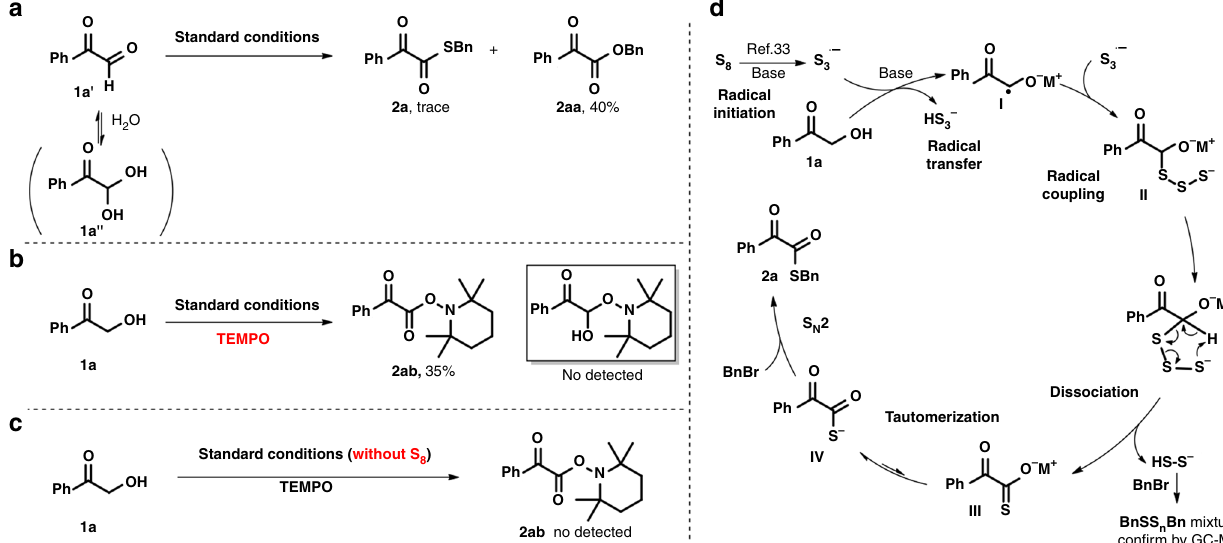
Fig. 3 Mechanistic studies. a The control experiment of α -formyl ketones. b Radical-trapping experiments. c The control experiment in the absence of elemental sulphur. d The plausible reaction